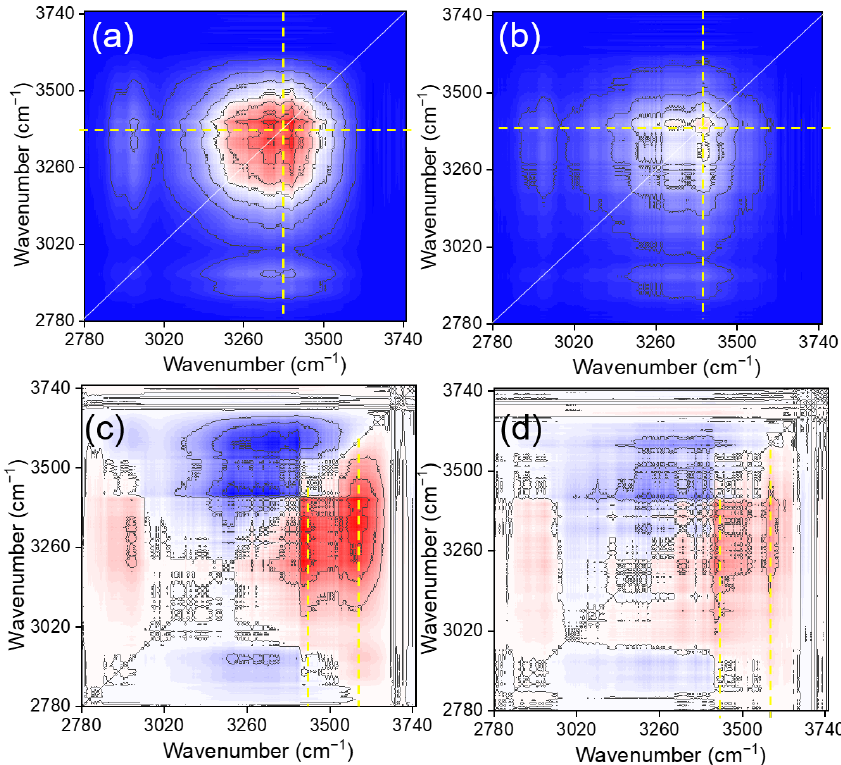
Figure 6. 2DSM and 2DAM for the Coum/SBE-β-CD inclusion complex (( a ) and ( c ), respectively), and corresponding physical mixture (( b ) and ( d ), respectively), in the 2780–3750 cm −1 wavenumber range. In the case of 2DSMs, positive cross-correlation intensities ( Φ(𝜈 1 , 𝜈 2 ) > 0 ) are marked in red, while null ones in blue ( Φ(𝜈 1 , 𝜈 2 ) = 0 ). On the other side, in 2DAMs, red, blue and white colored regions account, respectively, for positive, negative and null cross-correlation intensities. Yellow dashed lines are guide for the eyes. See text for details.